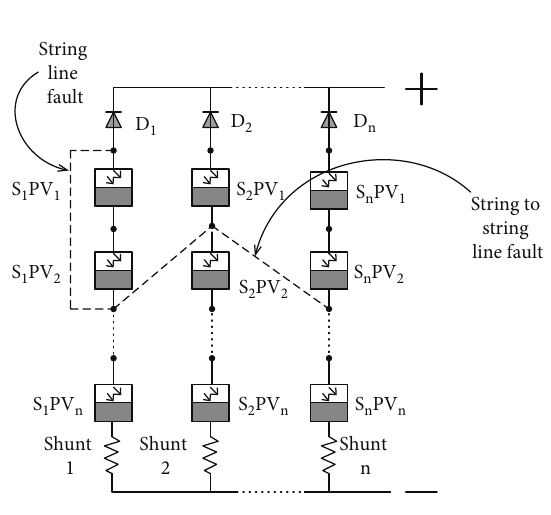
Figure 6: Line-line